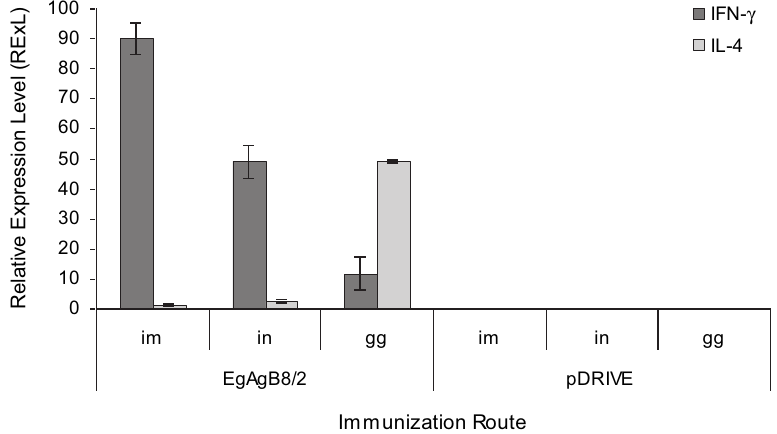
Fig 2. – Relative expression levels (RExL.) of IFN- γ and IL-4 genes determined in mice 50 days post-immunization with pDRIVE- EgAgB8/2 and empty plasmid (pDRIVE), using different routes of immunization (i.m., i.n. and g.g.). mRNA was prepared from spleen cells and reverse transcribed into cDNA. The expression level of IFN- γ and IL-4 genes were amplified using specific primers and detected using SYBER-Green I using the real time PCR machine. Each block represents the average expression level of three mice from each group. Comparative C T method ( ΔΔ C T ) was used to calculate the expres- sion level of each cytokine gene relative to β -actin gene as internal control as men- tioned in material and methods